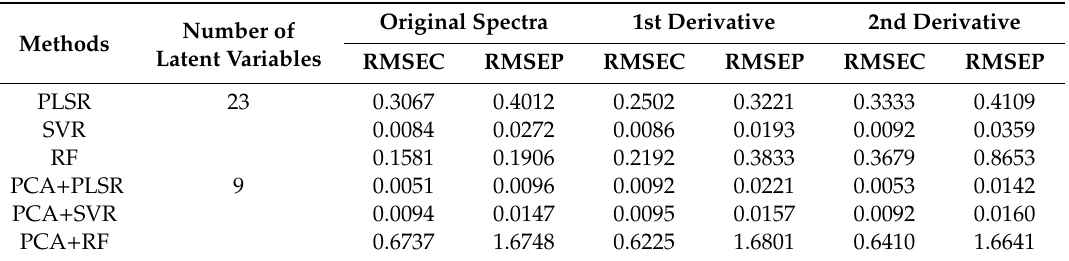
Figure 5. Predicted error of the optimal regression model for wheat extraction solution with residue of different concentration ( A : calibration set, B : validation set). Table 2. Predicted results of regression models developed with three preprocessed spectra for pirimiphos-methyl concentrations in wheat extraction (units: mg /